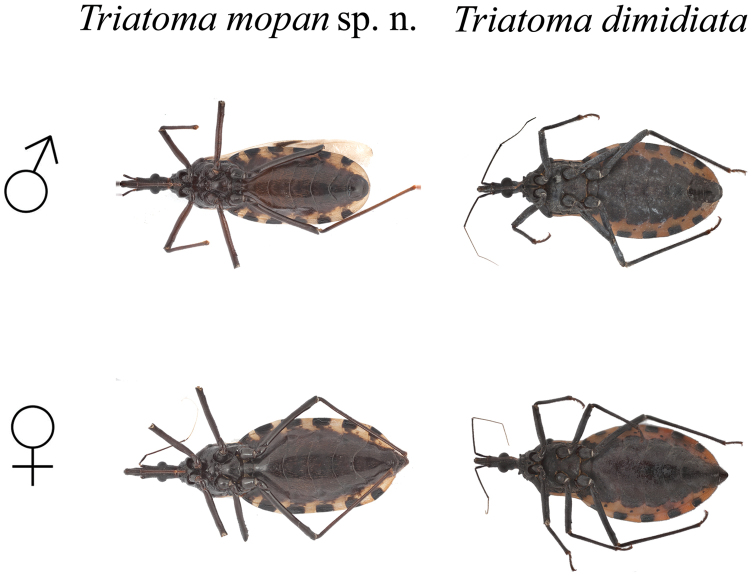
Comparison between ventral views of from T.
mopan and T.
dimidiata from Jutiapa, Guatemala males and females. Photographs: Silvia Justi and Raquel Lima.